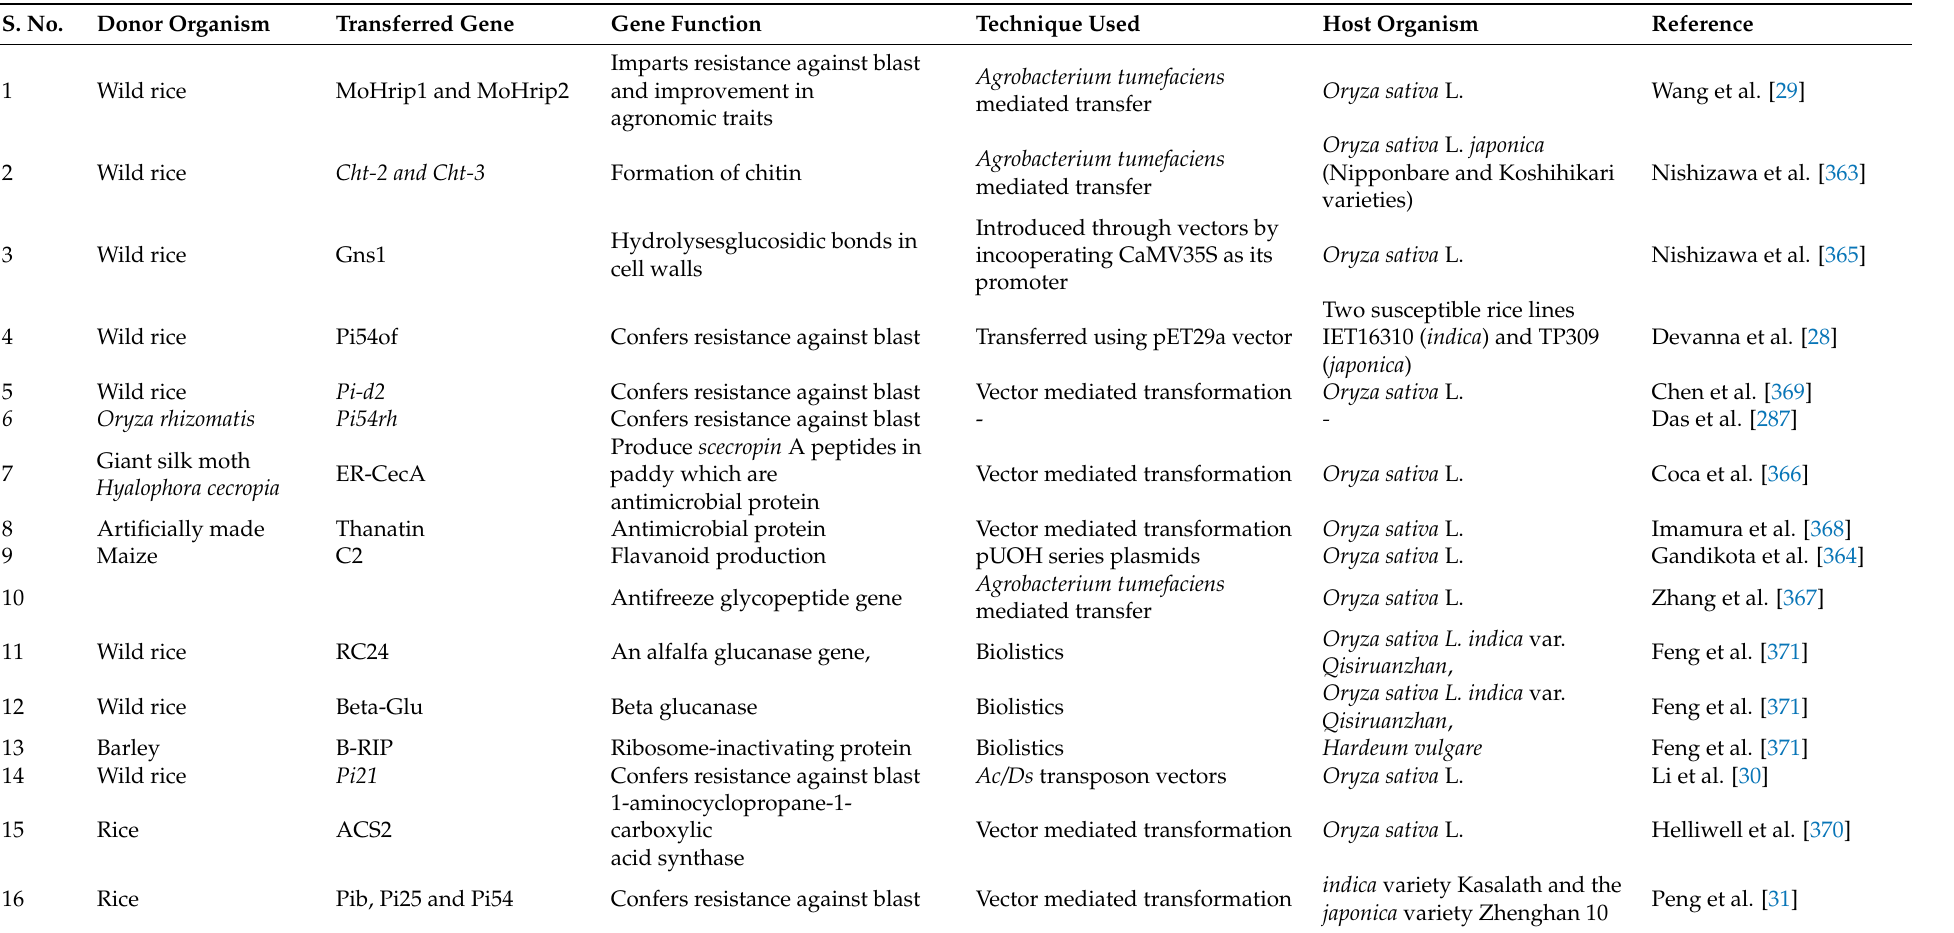
Table 5. Deployment of transgenic approaches for developing blast resistance in